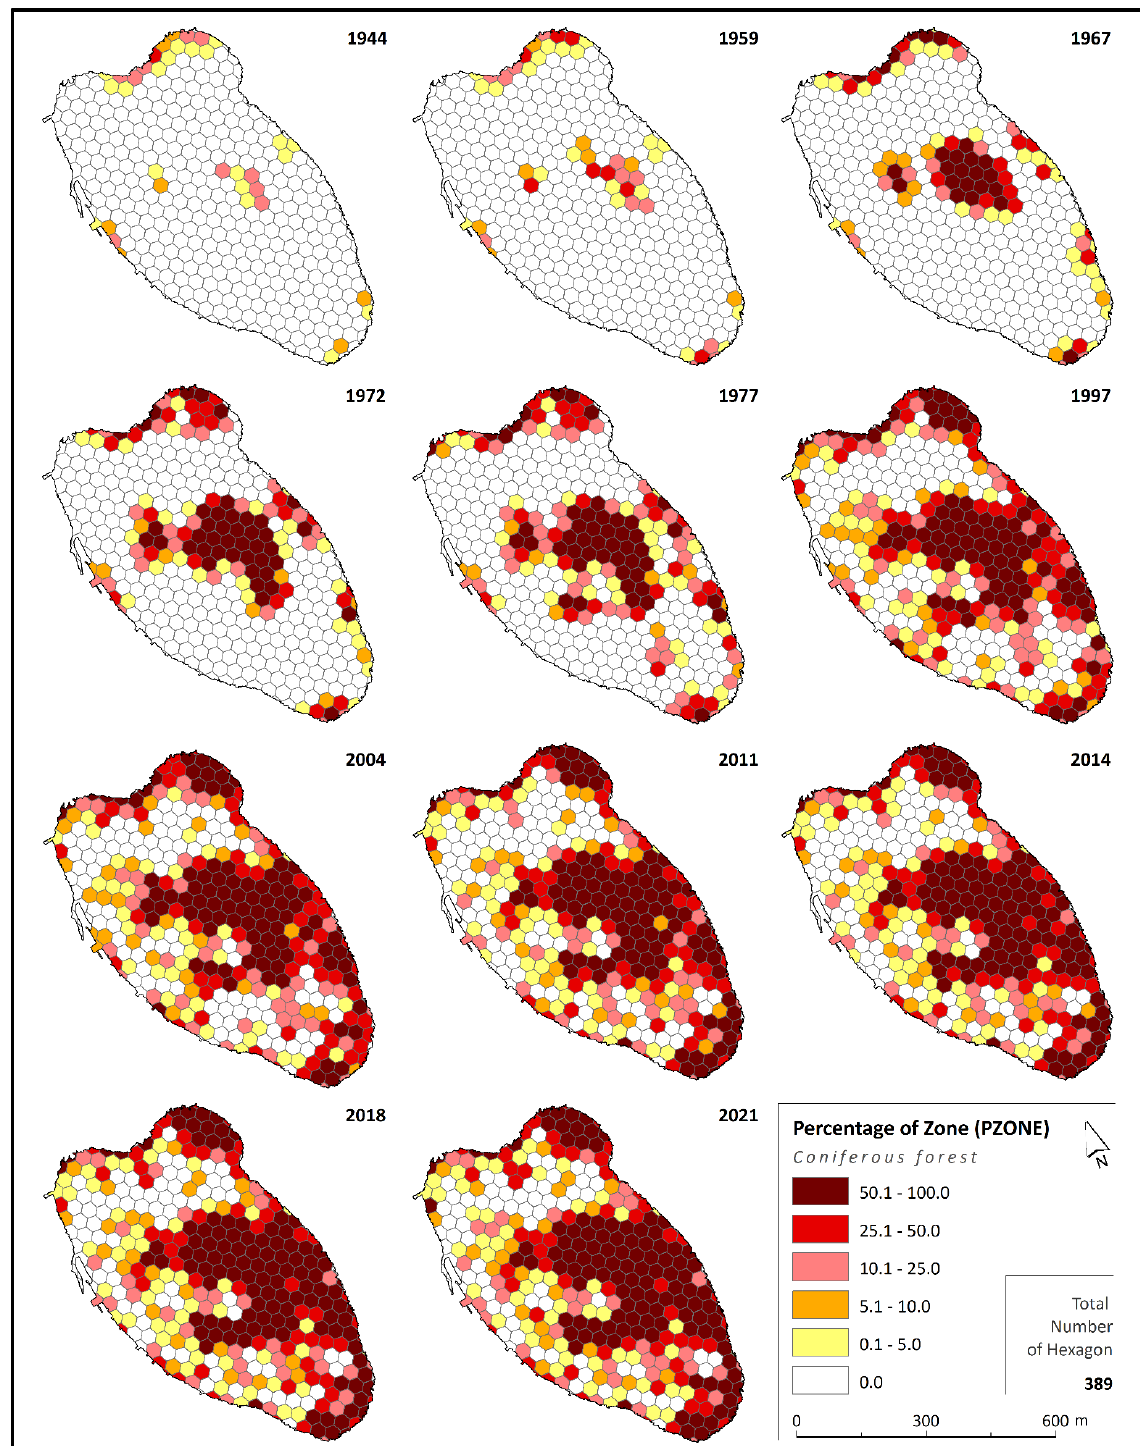
Figure 18. PZONE per zones for Ošljak (1944–2021)—coniferous forest.